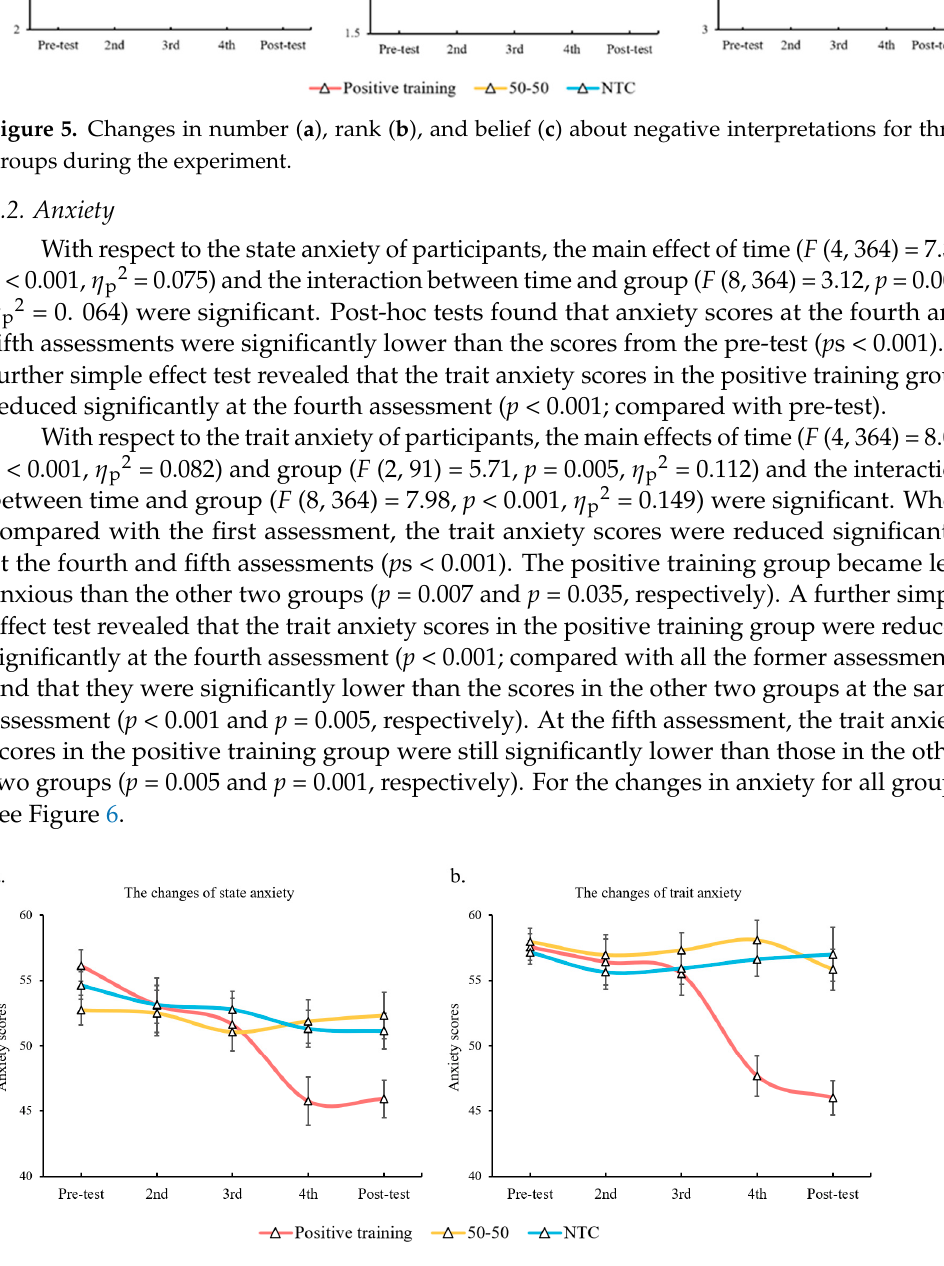
Figure 6. Changes of state ( a ) and trait ( b ) anxiety for three groups during the experiment.